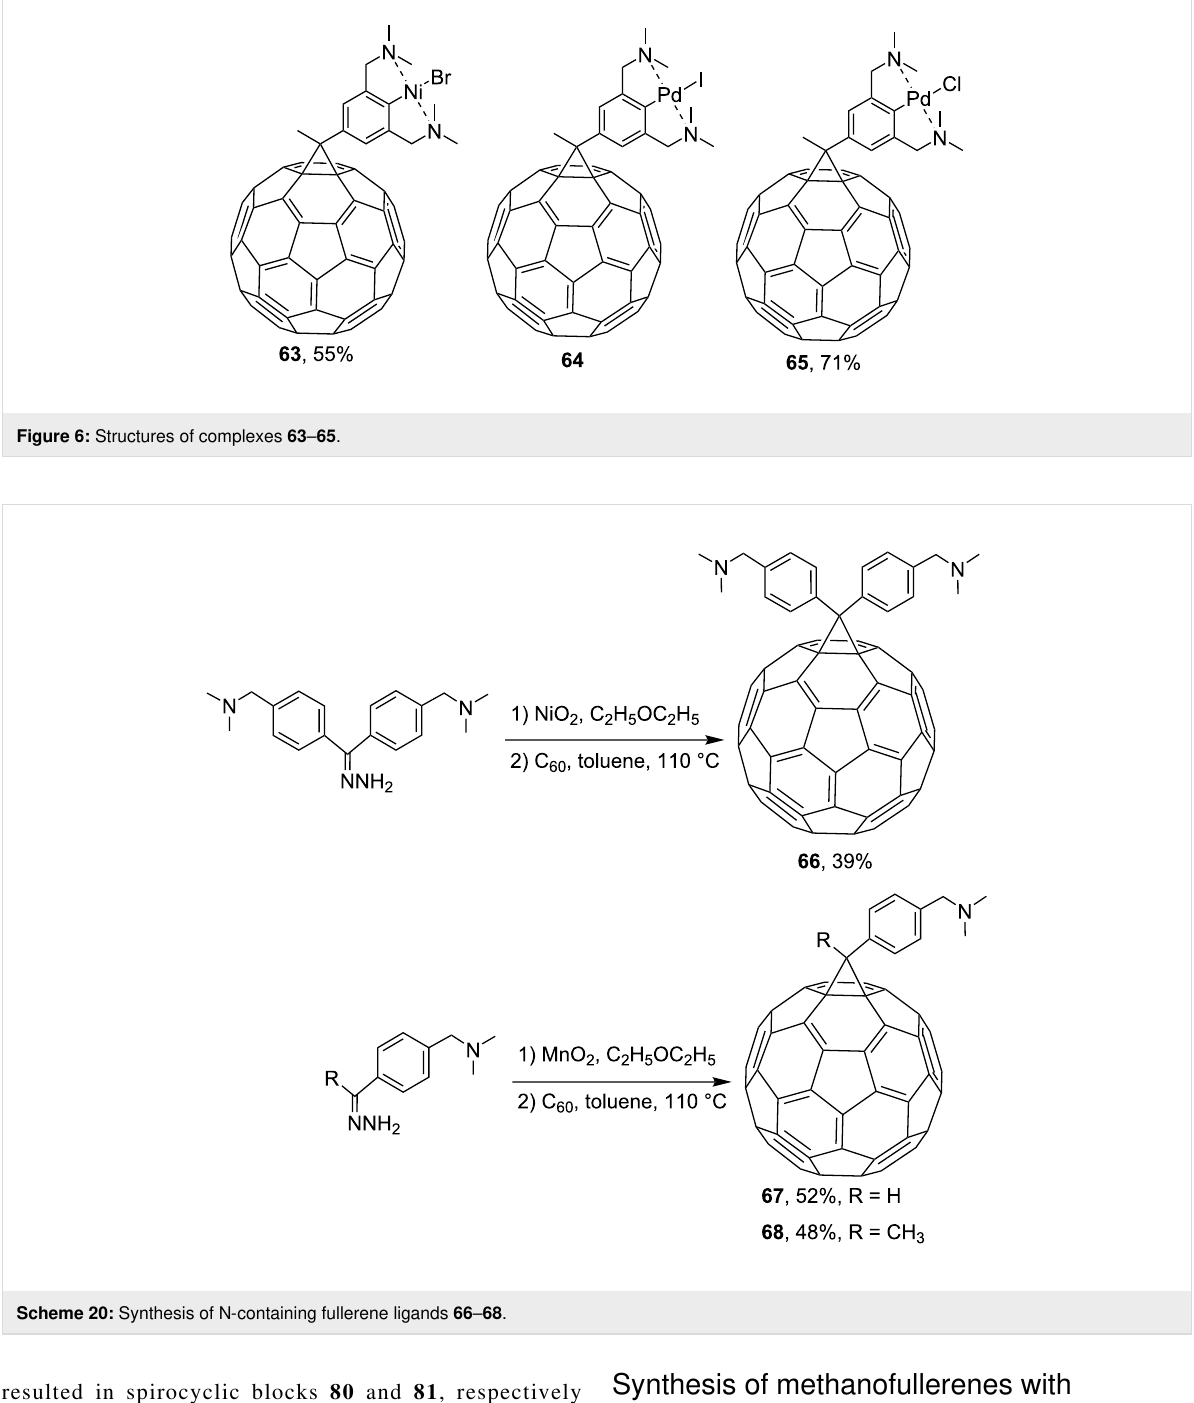
resulted in spirocyclic blocks 80 and 81 ,